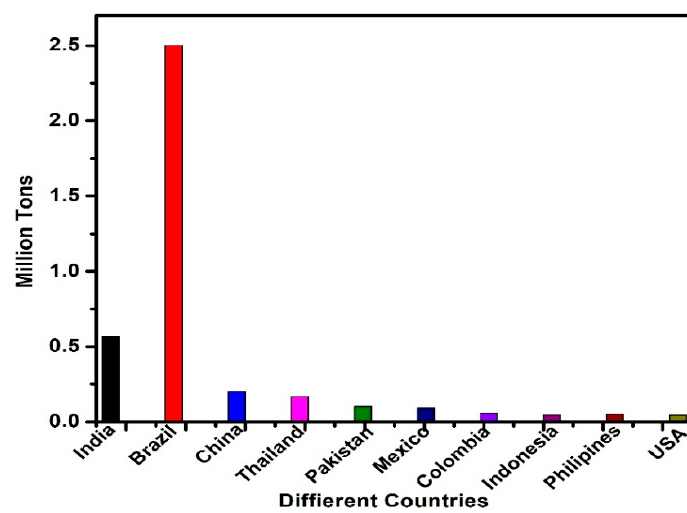
Figure 8. Worldwide production of SBA and source; data from [114] .